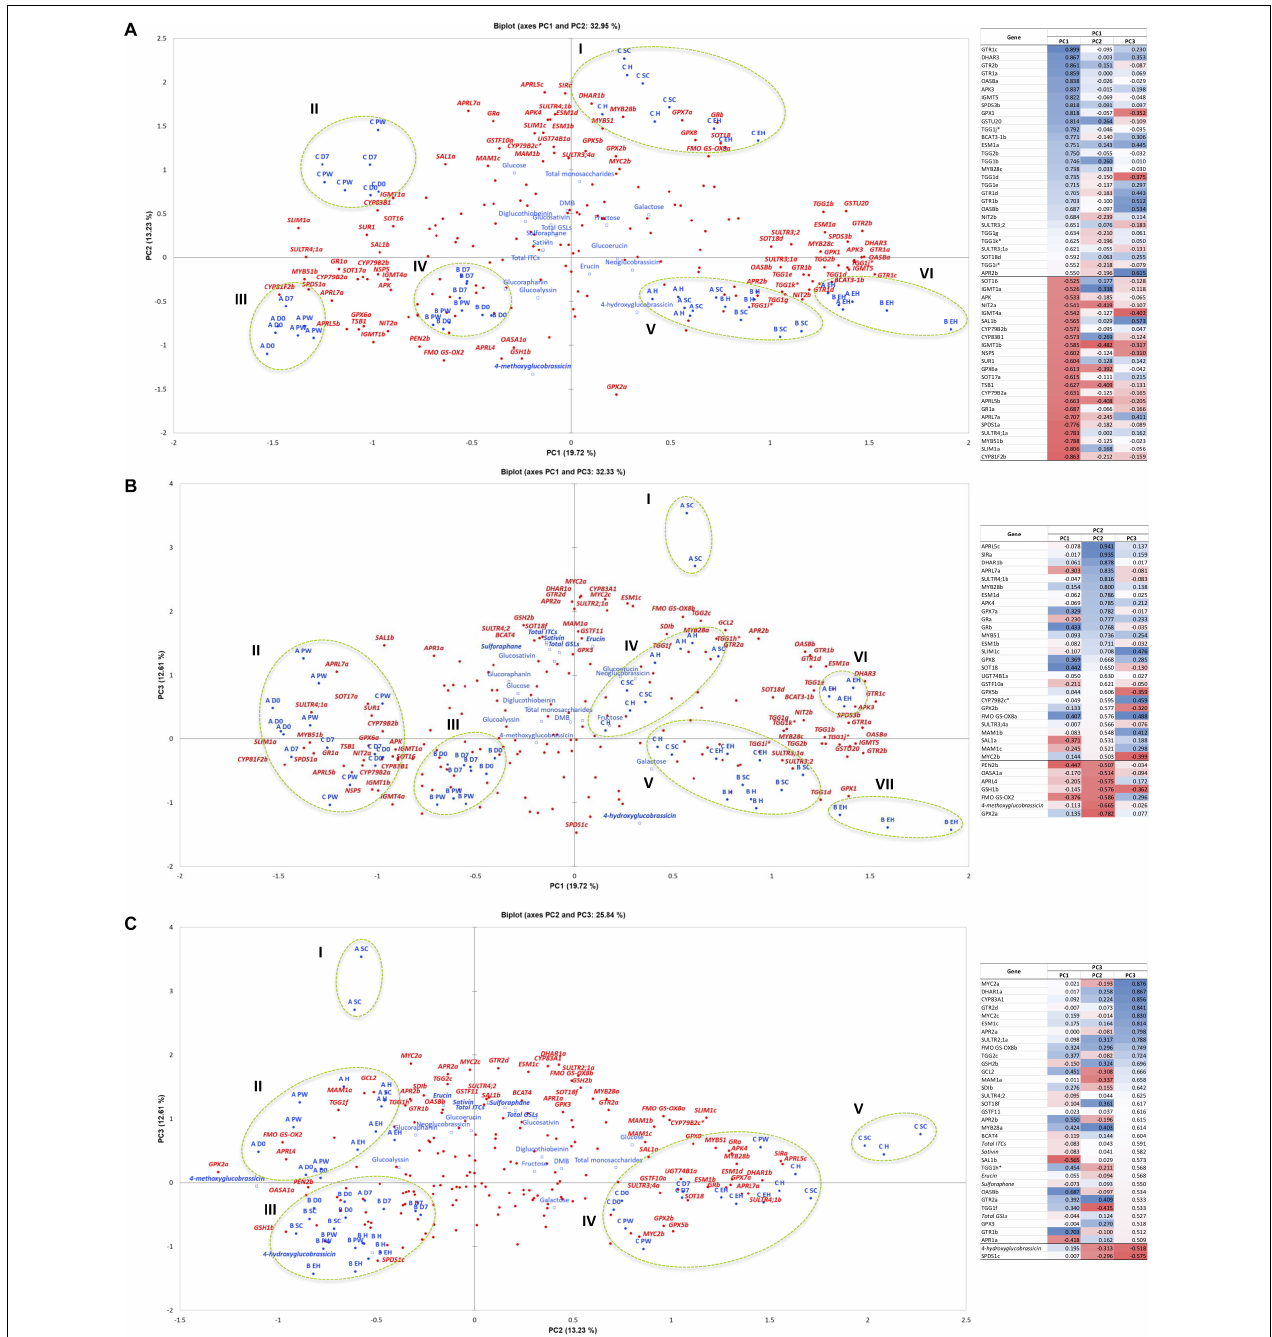
FIGURE 12 | Principal Component Analysis of sulfur assimilation pathway, glucosinolate biosynthesis, and glucosinolate hydrolysis gene expression data (FPKM) for three Eruca sativa elite inbred lines ( A , B , and C ) across ontogenic and postharvest sample points. Biplot (A) displays Principal Components (PCs) 1 and 2, which represent 33% of variation within the data. Biplot (B) displays PC1 and PC3, explaining 32.3% of variation within the data; and (C) displays PC2 and PC3, explaining 25.8% of the variability. The PCA plots presented are the results of Varimax rotation. Each biplot is accompanied by a factor loadings table sorted according to PC1 (A) , PC2 (B) , and PC3 (C) ; italics denotes a supplementary variable, and asterisks denotes a putative novel gene within the reference annotation. Blue coloration denotes high factor loading scores, red denotes low. Only genes with loading values > 0.5 were included, and each is represented within the biplots in red (bold italics). Red circles represent individual genes included in the analysis ( n = 177). Blue circles represent sample point variables and have accompanying labels (blue bold). Blue squares denote phytochemical data regressed onto the PCA as supplementary variables. Bold data labels indicate phytochemical components with > 0.5 factor loadings scores. Green dotted ellipses denote clusters of variables and are numbered using Roman numerals, which are quoted within the text. EH , early harvest; H , harvest; SC , second harvest; PW , pre-wash; D0 , post-wash; and D7 , 7-day shelf life.